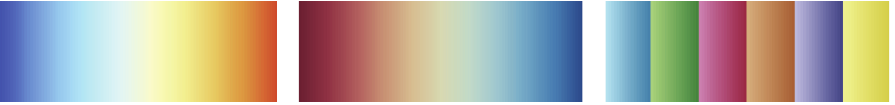
Figure 1: The colors “ LightTemperatureMap, ” “ RedBlueTones, ” and “ DarkBands ” (from left to right, respectively).